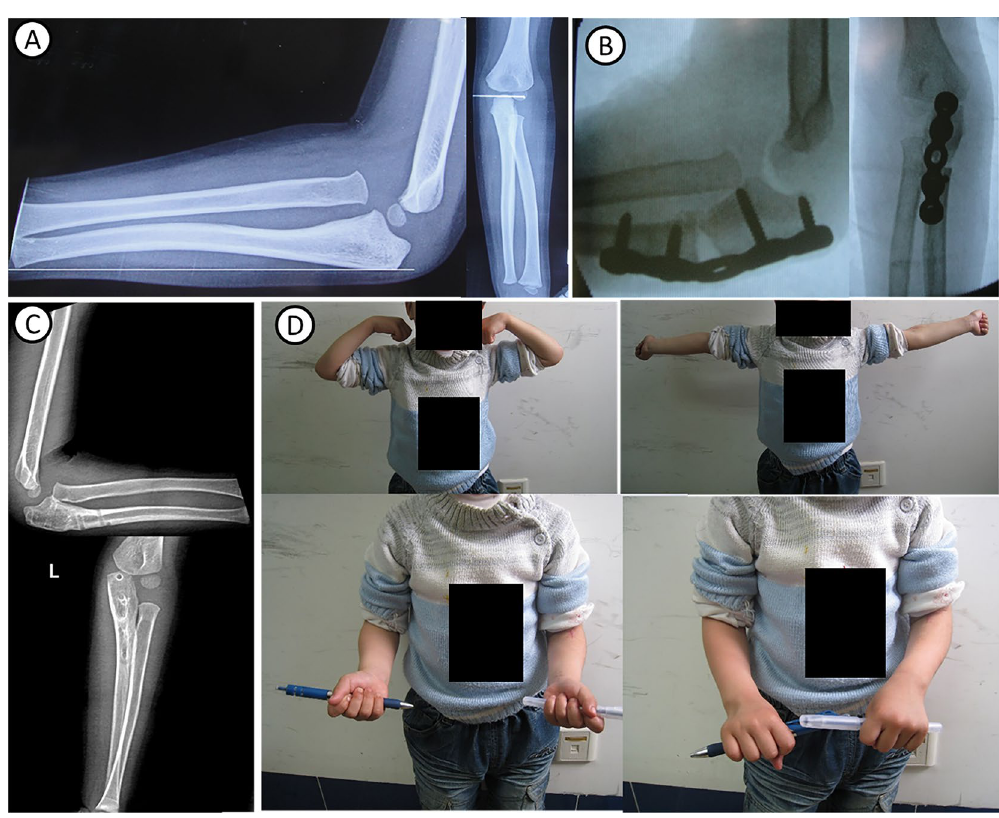
Figure 2. Typical case 1: A 3.5-year-old boy with left missed Monteggia fracture. ( A ) Bado I type, ulna bow sign is located in the middle of ulna (group A). ( B ) In operation, reverse angulation is 24°, and radial head reduction is observed. ( C ) No dislocation of the radial head is found after the osteotomy is healed and the internal fixation is removed. ( D ) The elbow joint function is good after operation, no loss of rotation